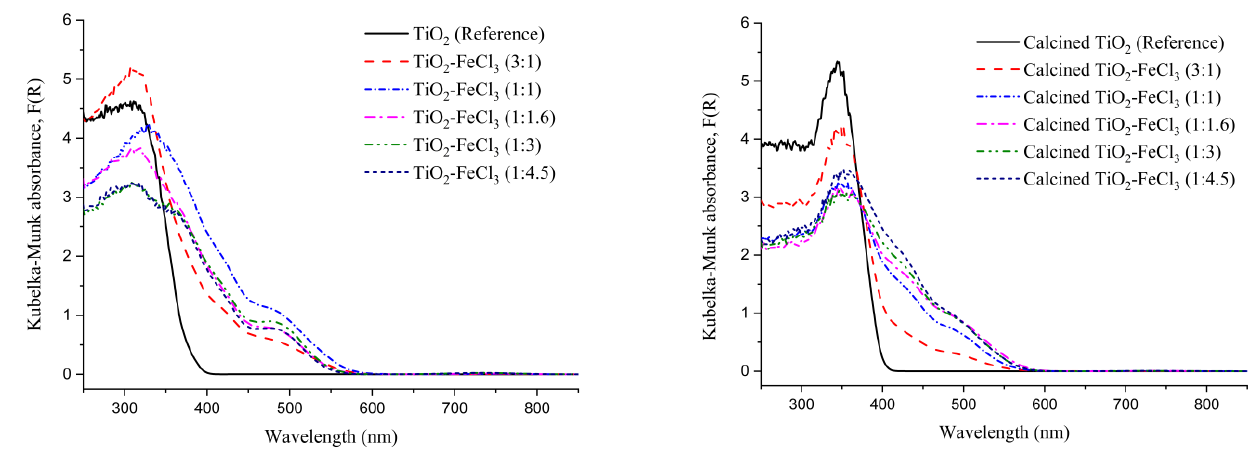
Figure 4. Kubelka–Munk function versus wavelength for the undoped TiO 2 (reference) and the samples synthesized before calcination ( left ) and after calcination ( right